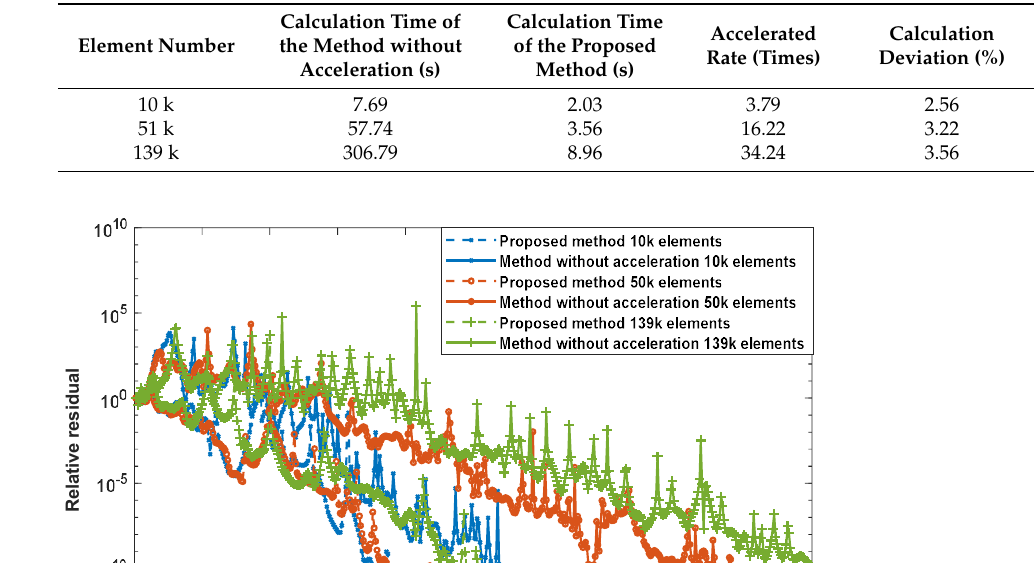
Table 1. The computation and accelerated times under different mesh elements [22].